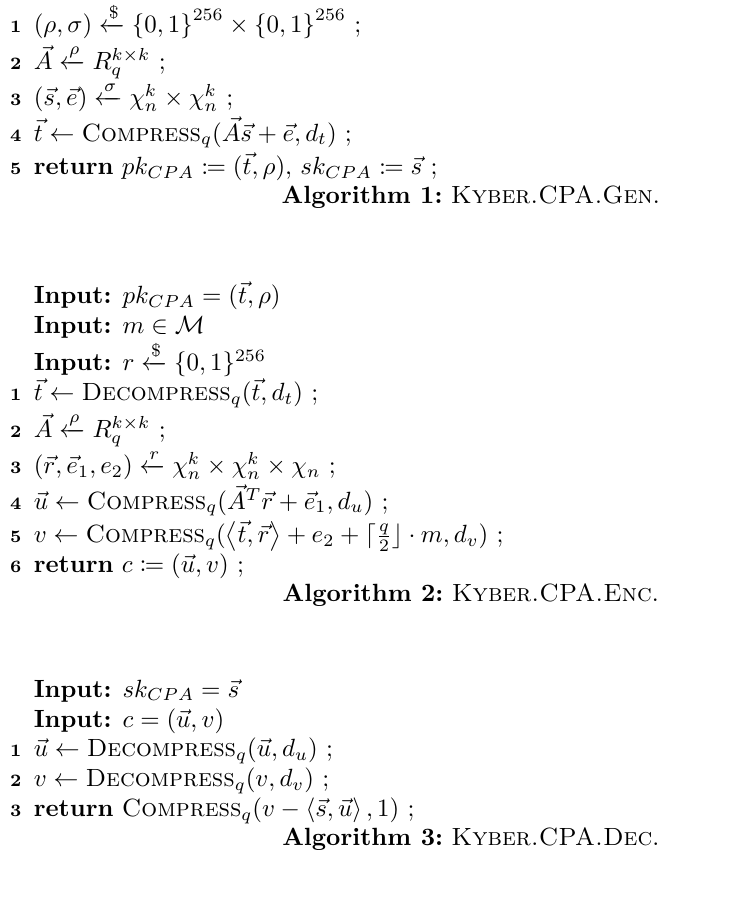
Algorithm 3: Kyber.CPA.Dec